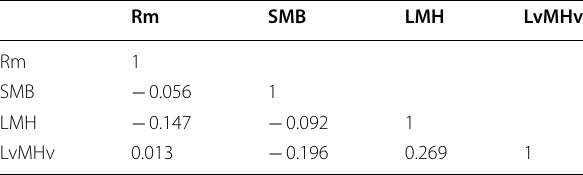
statistics for the independent Table 3 Correlation matrix for explanatory